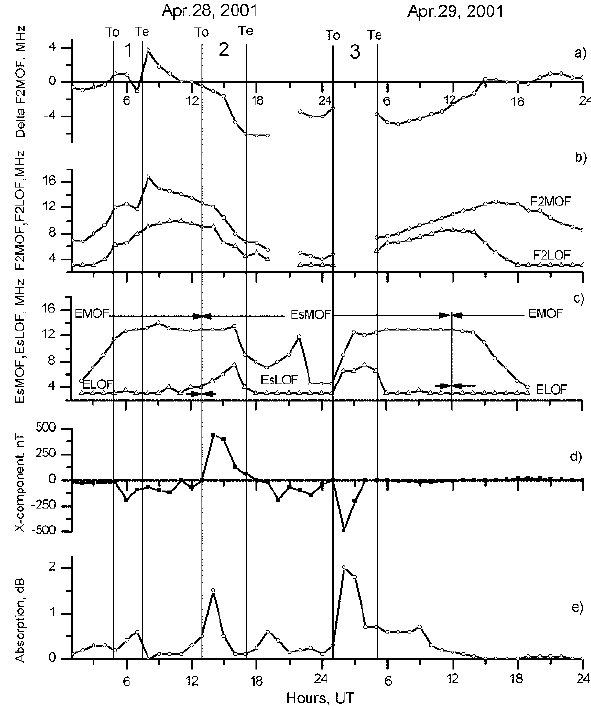
Fig. 5. Oblique sounding measurements made on the path Murmansk-St. Petersburg during a magnetic storm of ( a ) DeltaF2MOF, ( b ) F-region MOF and LOF, and ( c ) E-region MOF and LOF. Measurements made at Sodankyla, Finland (near to path mid-point) of ( d ) X-component of geomagnetic field, and ( e ) ri- ometer absorption A (dB) at